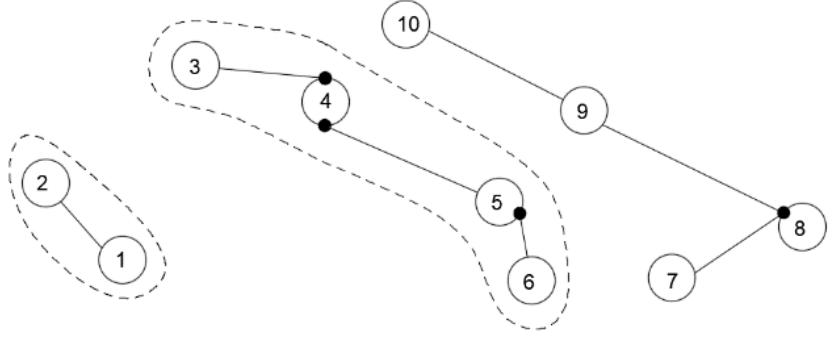
Figure 16. Decomposition of undirected graphs.